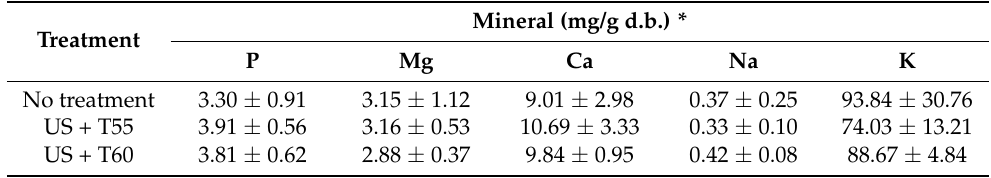
* Values are mean ± half of the confidence intervals at